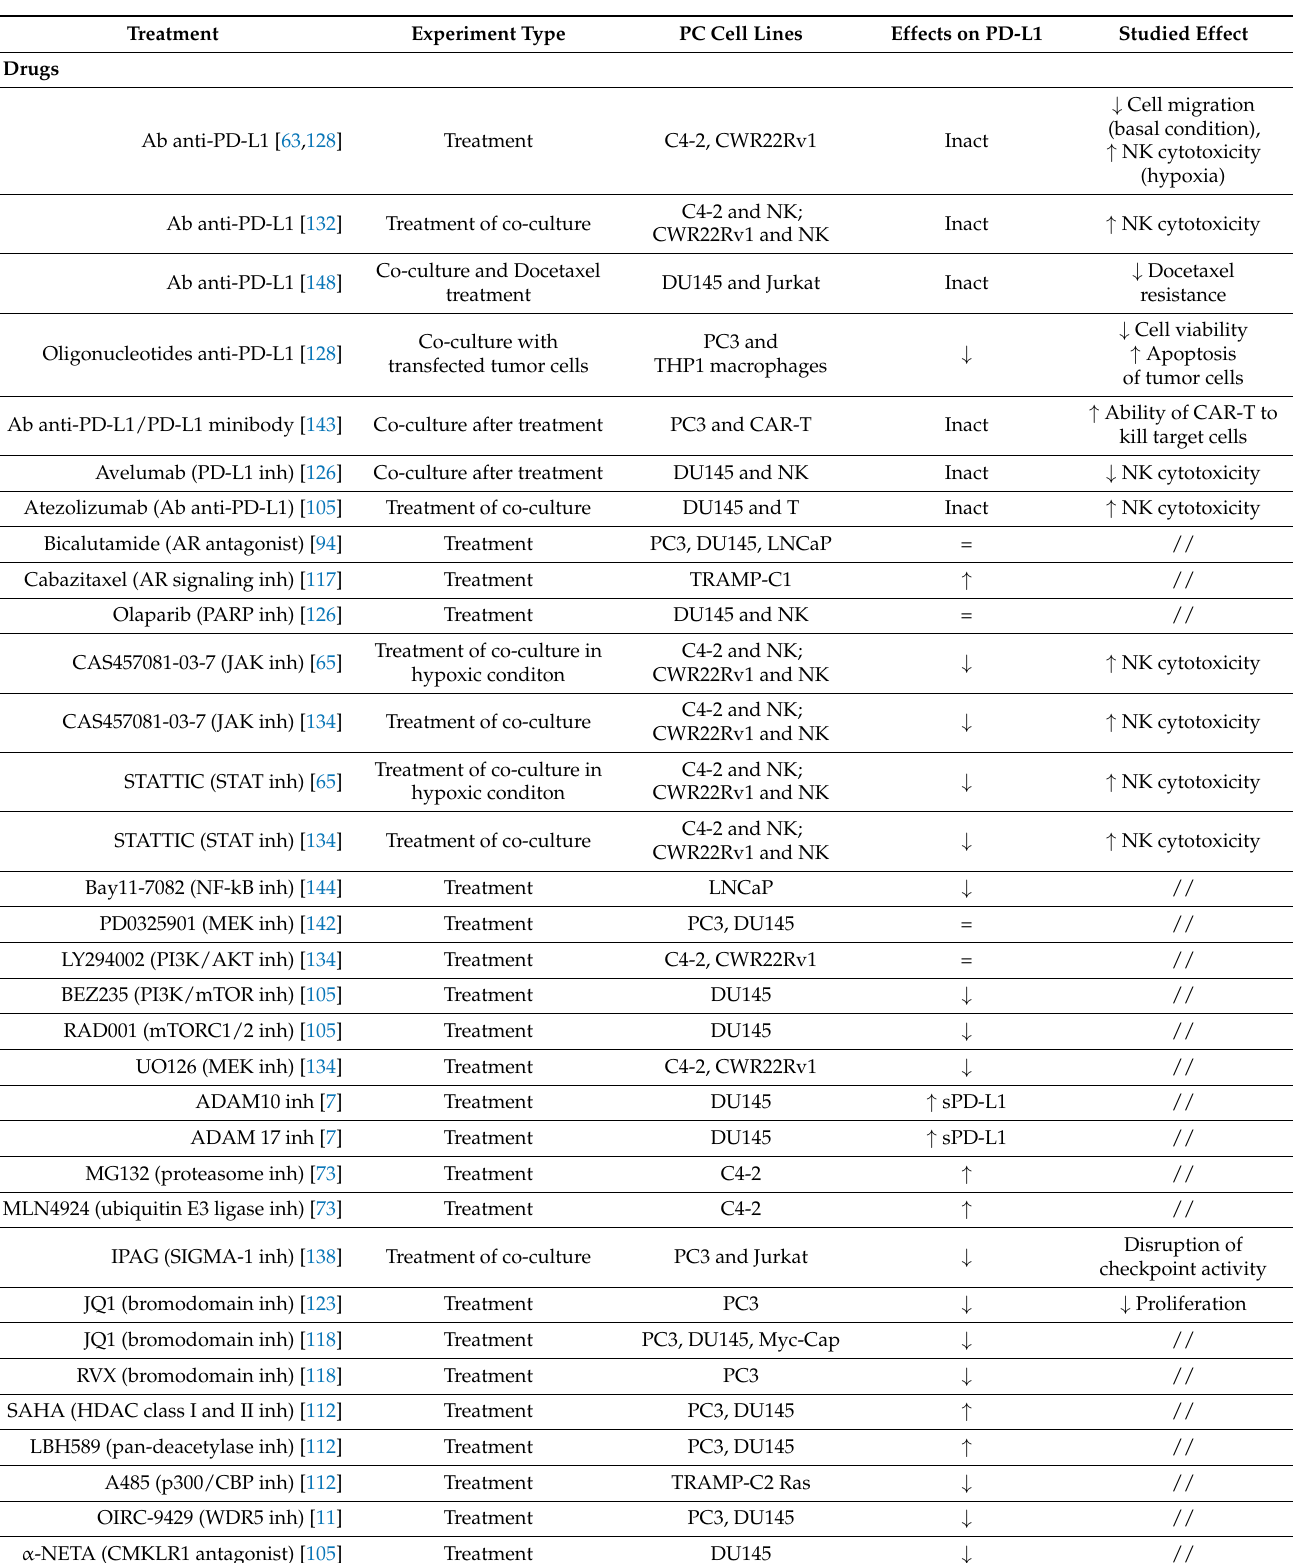
Table 1. Experimental treatments involved in the regulation of PD-L1 in prostatic carcinoma (pre-clinical